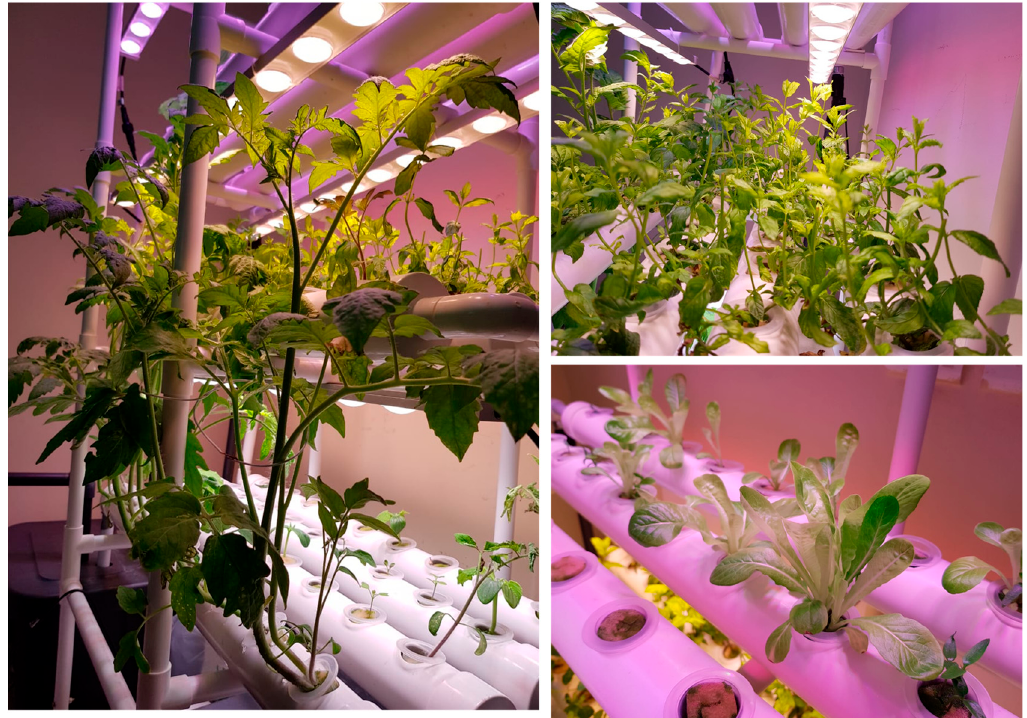
Figure 12. Snapshot of the system in use for growing different plants from seeds and stem in the hydroponic system.